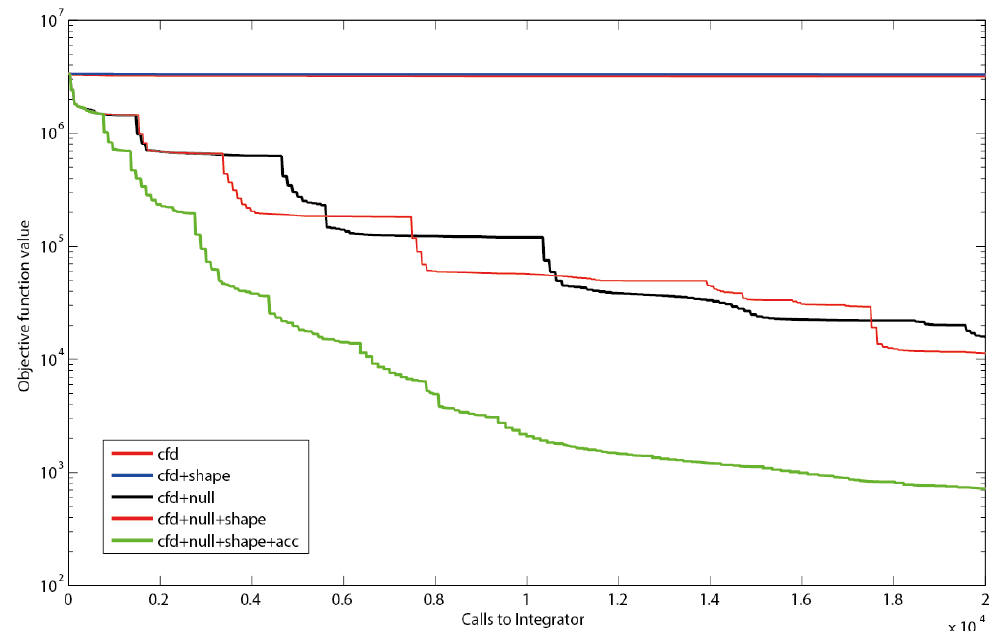
Figure 4. Objective function as a function of executed integrations. Using only central finite differences (cfd), resembling the search directions of a quasi-Newton solver or cfd together with shape constraints (shape) leads to a slow decrease in the residual sum of squares. The use of null-space-based sampling (null) significantly increases the convergence